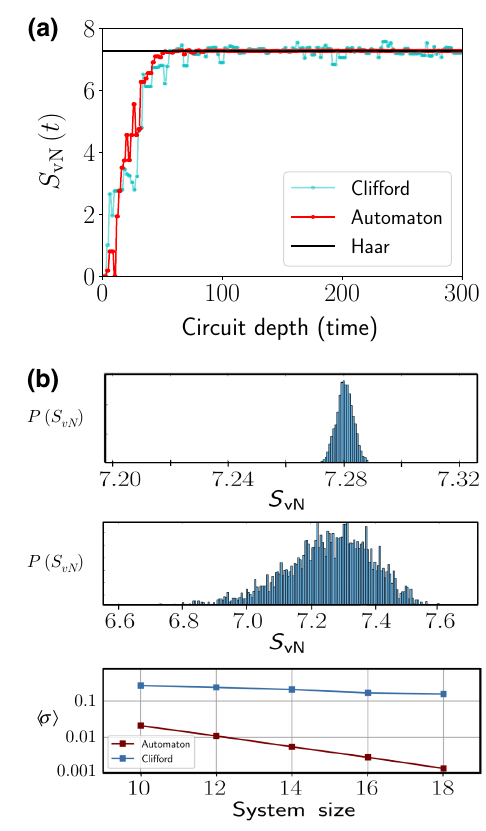
FIG. 3. (a) The bipartite entanglement entropy S v N as a func- tion of time for both Clifford and automaton circuits. In both cases, the late time entanglement averages to the Haar random “Page entropy”; however, the temporal fluctuations are signifi- cant in the Clifford circuit, while they appear negligibly small in the automaton circuit. (b) This uniformity of entanglement can be seen in a single realization of an automaton wave function, if we measure the entanglement in all possible bipartitions of the lattice. We show the probability distribution of the entanglement entropy across the different partitions for the automaton ( top ) and Clifford ( middle ) wave functions. The standard deviation of these (cid:2) − (cid:5) S (cid:2) ) 2 (cid:2) , decays expo- (cid:5) ( S distributions ( bottom ), (cid:5) σ (cid:2) = v N v N nentially with system size for automaton circuits and appears to saturate to a constant value for Clifford